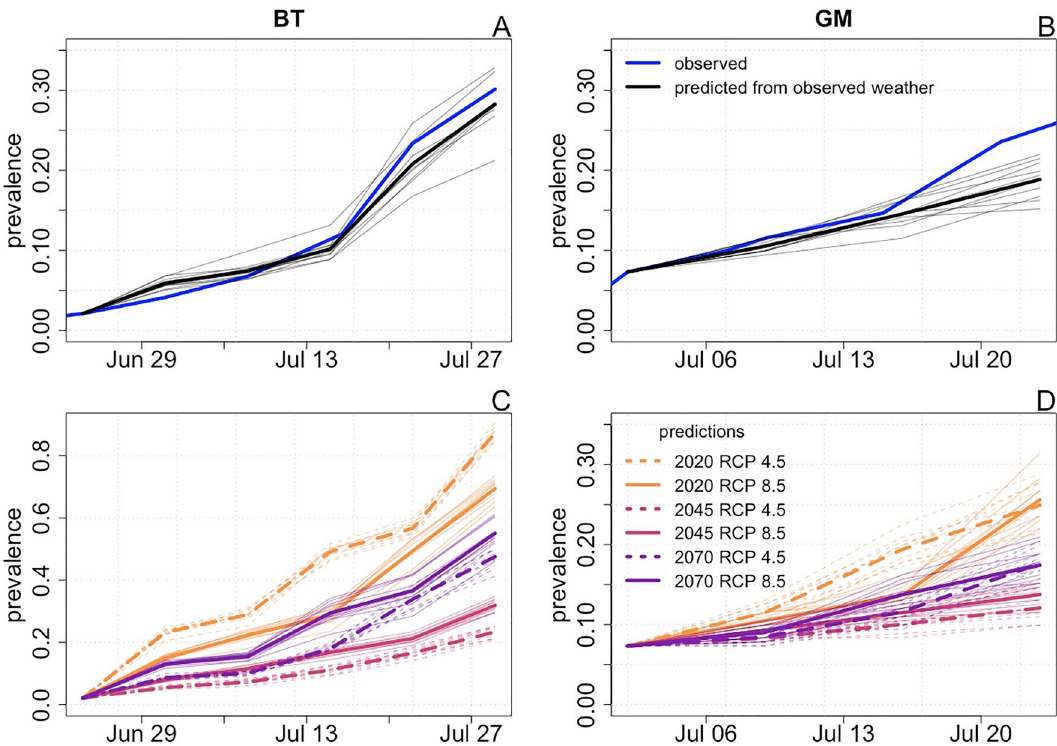
Figure 6. The effects of climate change on the epidemiology of flax rust disease. Panels ( A ) and ( B ) show the observed patterns of infection prevalence at the BT and GM sites (blue lines) along with prevalence simulated from 10 runs of the spatiotemporal epidemiological model using observed weather data (thin black lines). The thick black lines show the mean of the 10 simulations. Panels ( C ) and ( D ) show patterns of infection prevalence at the BT and GM sites simulated for six future climate scenarios. We simulated 10 epidemics at each site for each climate scenario. Thin lines show prevalence predicted from individual simulations, and thick lines show mean prevalence across 10 simulations for a given climate